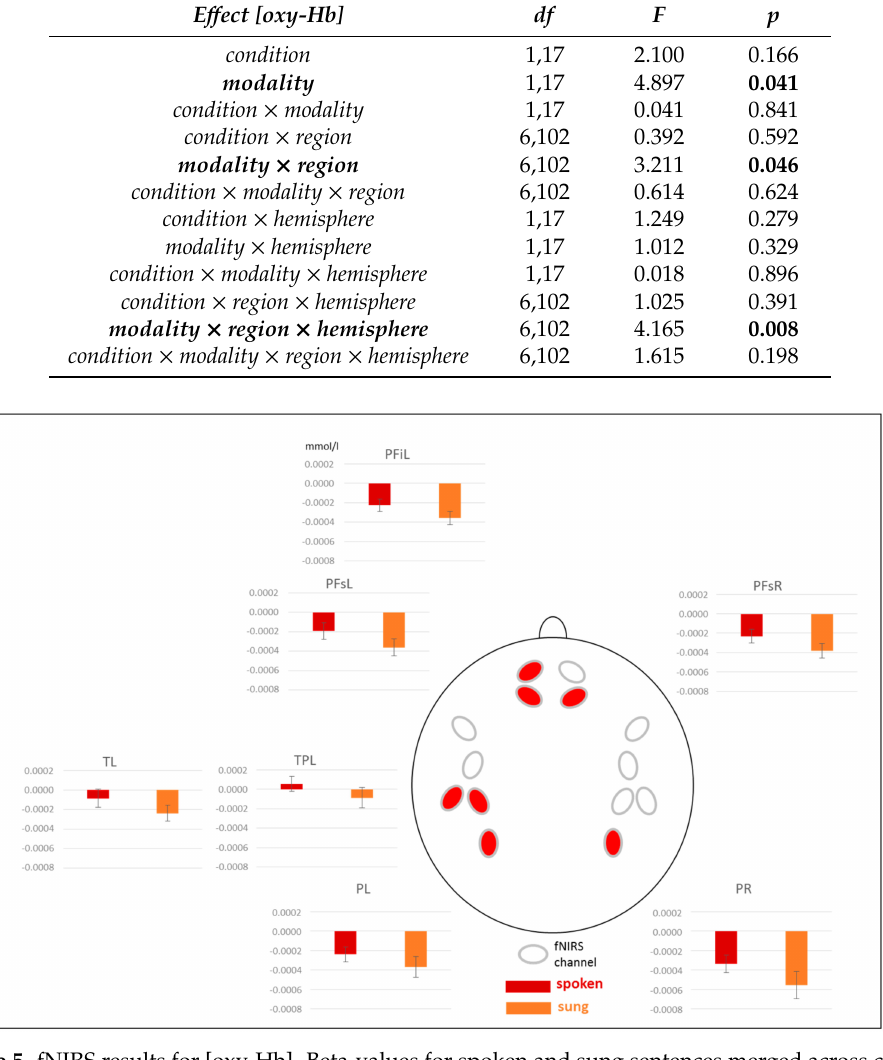
Figure 5. fNIRS results for [oxy-Hb]. Beta-values for spoken and sung sentences merged across correct and incorrect sentences. Red channels indicate significant di ff erences. PFi = prefrontal inferior, PFs = prefrontal superior, T = temporal, TP = temporo-parietal, P = parietal, L = left, R = right. Please note that a more positive value indicates an increased